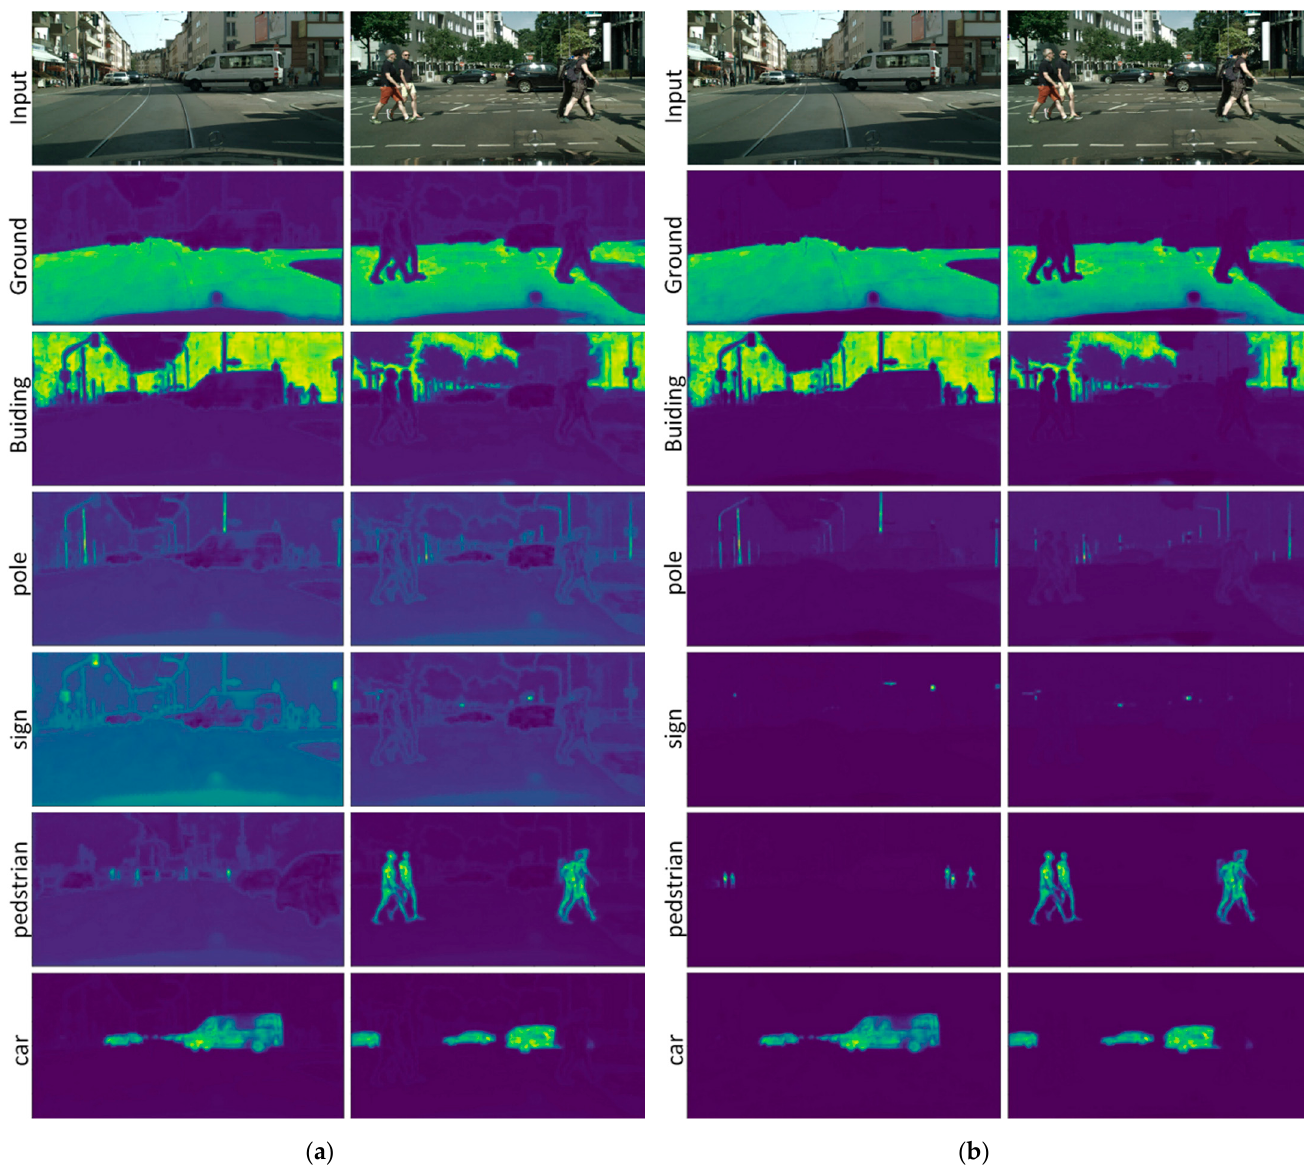
Figure 4. The visualization of the Class-to-Class Attention and the Target-to-Background Attention. ( a ) C2C Attention, ( b ) T2B Attention.